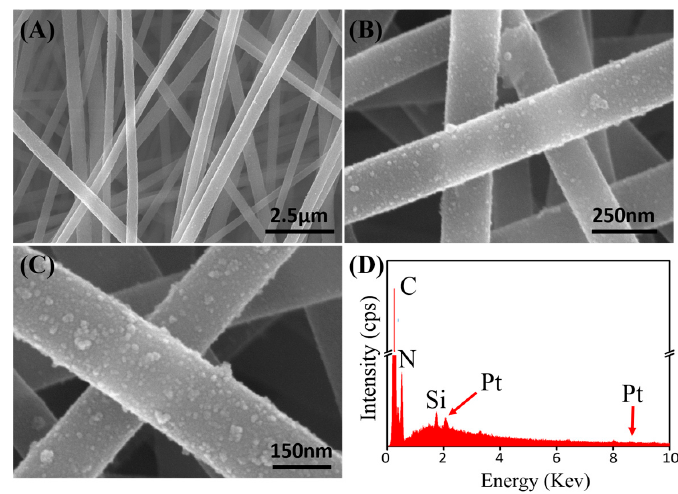
Figure 2. ( A ) SEM image of electrospun PAN/APS nanofibers; ( B , C ) SEM images of PAN–PtNPs hybrid nanofibers with different magnifications; ( D ) Corresponding energy dispersive X-ray detector (EDX) analysis.